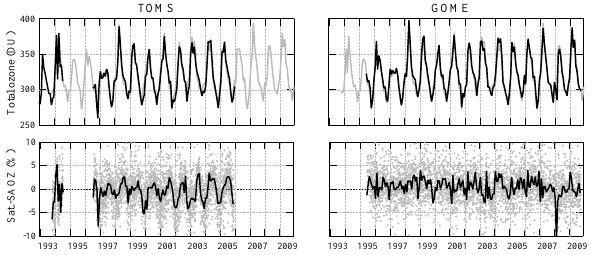
Fig. 10. Example of comparison between SAOZ V2 and satellite overpass total ozone at OHP. Top: monthly mean total ozone (grey line: SAOZ; black line: satellite), bottom: satellite-SAOZ relative difference (grey dots: daily; black lines: monthly mean). Left: TOMS, right: GOME-GDP4.